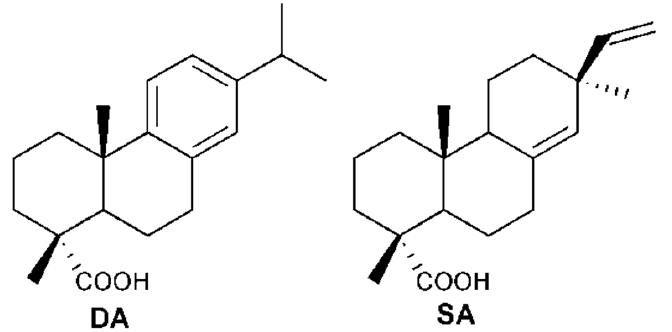
Figure 1. The chemical structures of DA and SA